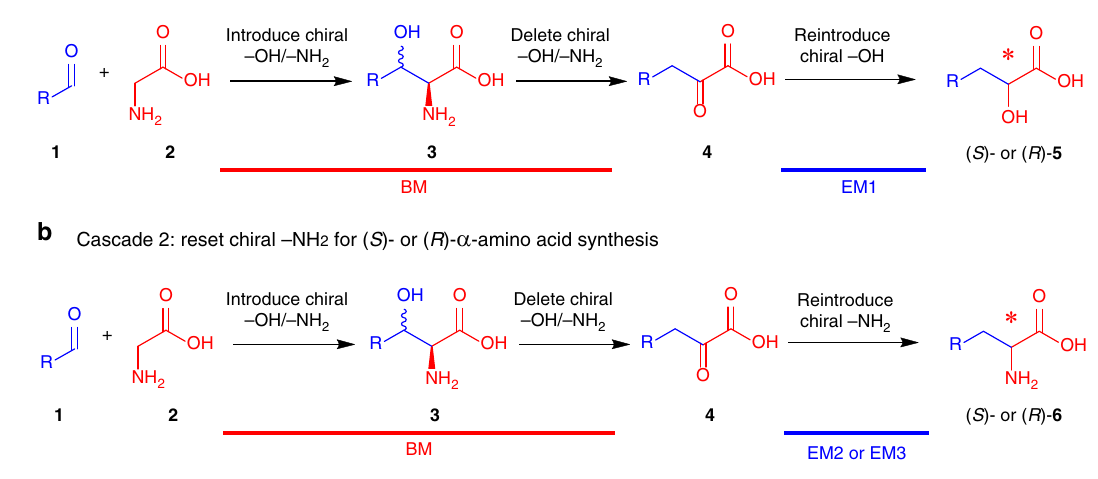
Fig. 2 The arti fi cially designed chiral-group-resetting cascades. a Cascade 1: reset chiral – OH for stereode fi ned α -hydroxy acid synthesis via cascade BM with EM1. b Cascade 2: reset chiral – NH 2 for stereode fi ned α -amino acid synthesis via cascade BM with EM2 or